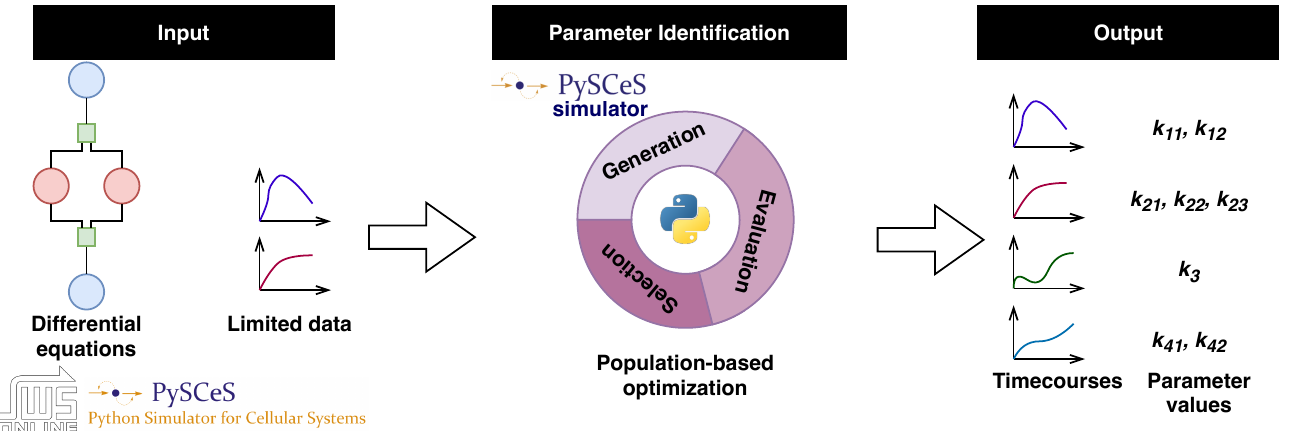
Figure 1. A schematic representation of our framework. A dynamic model in the PySCeS format and experimental data are inputs to the program. The core component is the parameter identification with population-based optimization methods. Eventually, parameters values are returned, for with the lowest error (i.e., the difference between simulated data and experimental data) was